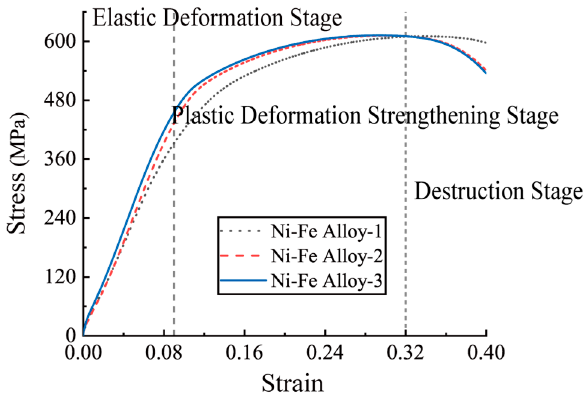
Figure 11. Ni-Fe tensile specimen dimensions and damage specimen diagram(unit: mm).